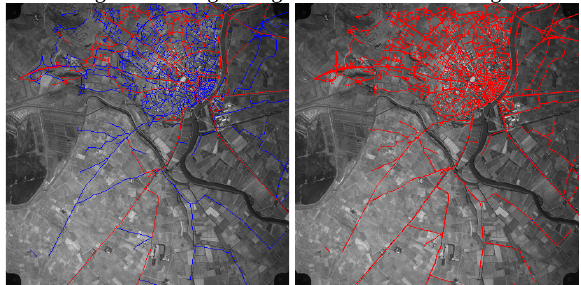
Left : initial projection of TopoDB road network on the image Right : meaningful alignments detected in image